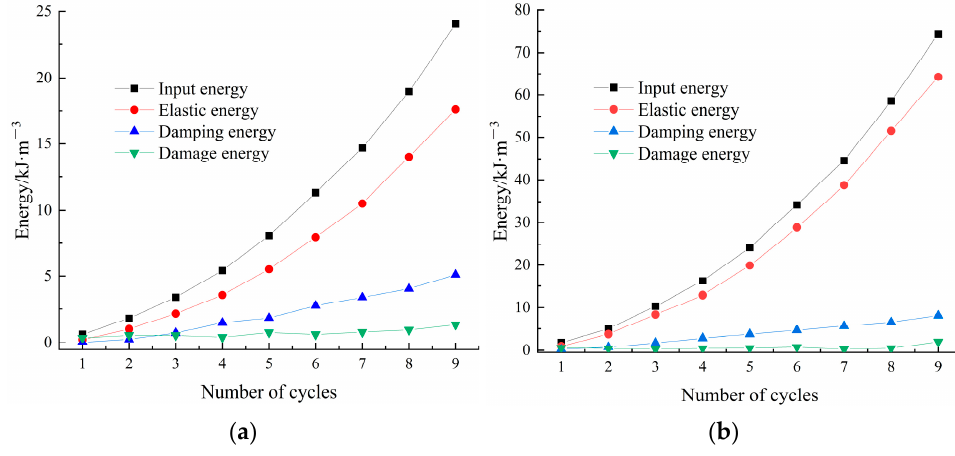
Figure 13. Rock energy evolution under CLLCL. ( a ) Sandstone; ( b ) granite.